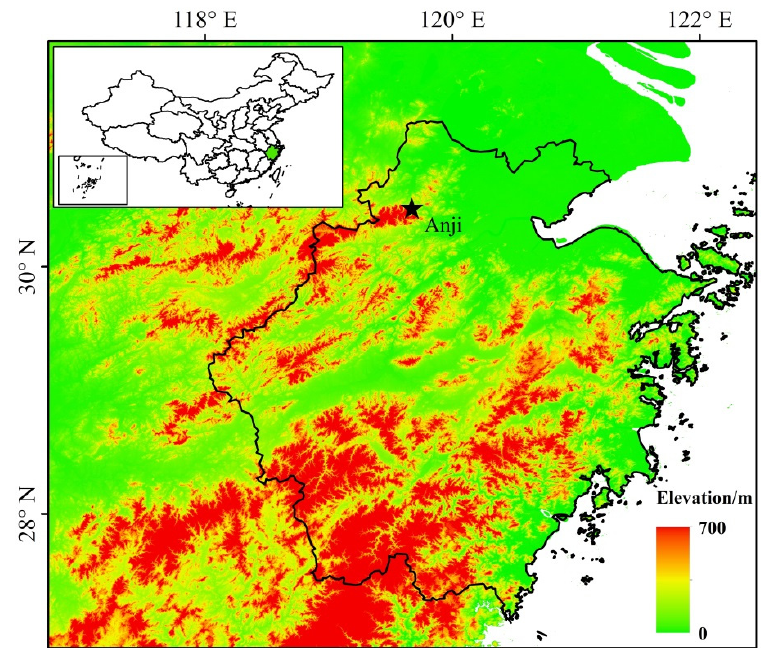
Figure 1. Location of the study site in Anji County, Zhejiang Province, China.